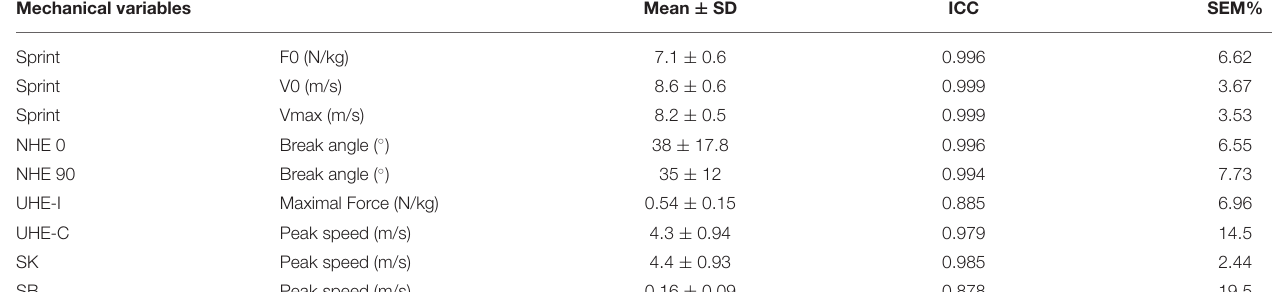
TABLE 2 | Means, standard deviations, and reliability measures for sprint and exercises data. Mechanical variables